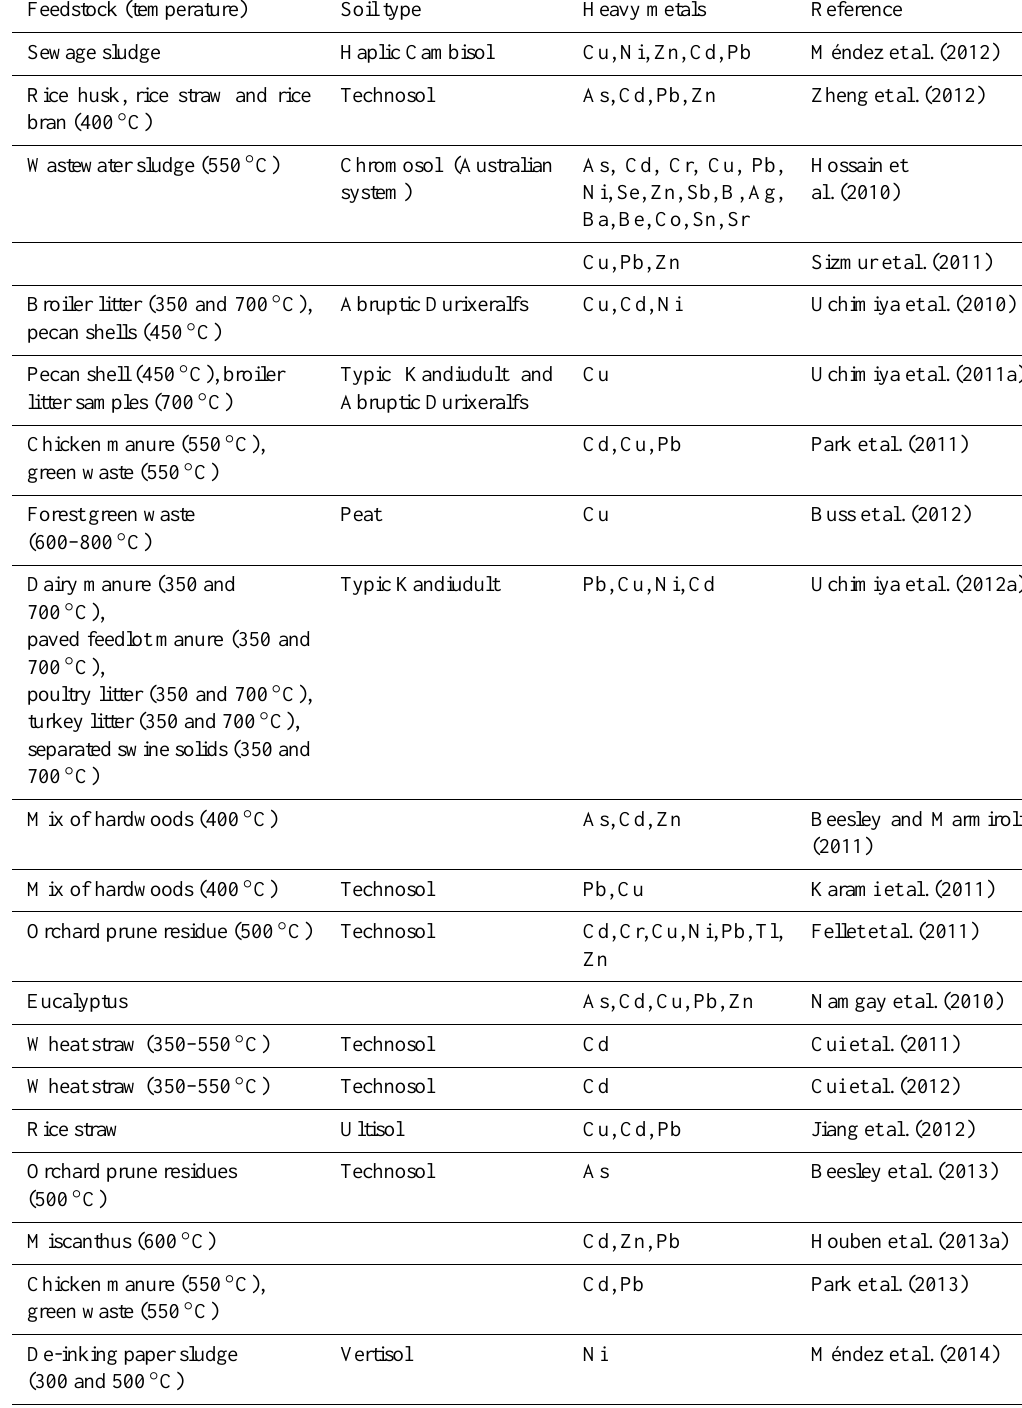
Table 1. Studies considering the effect of biochar application on soil heavy metals. Blank indicates not specified in the